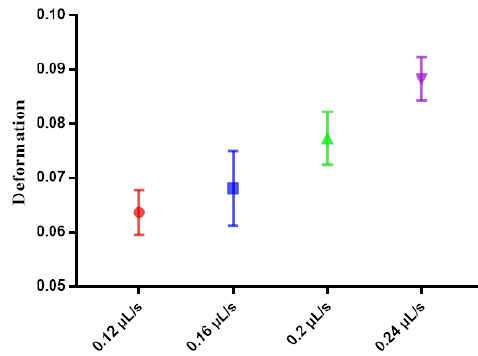
Figure 5. The deformation of PC3 cells using different flow rates.